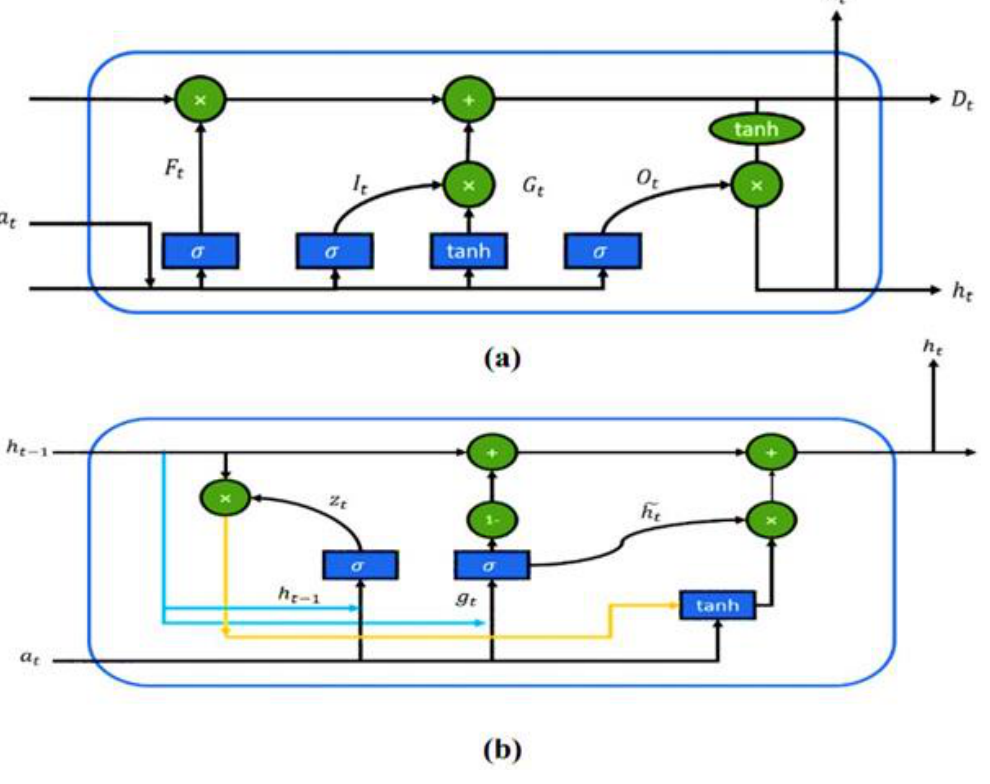
Figure 2. Comparison parameter between ( a ) LSTM and ( b ) GRU framework [35] . Hidden unit activation ( 𝒓 𝒕 ) is processed at a time step using Equation (2):